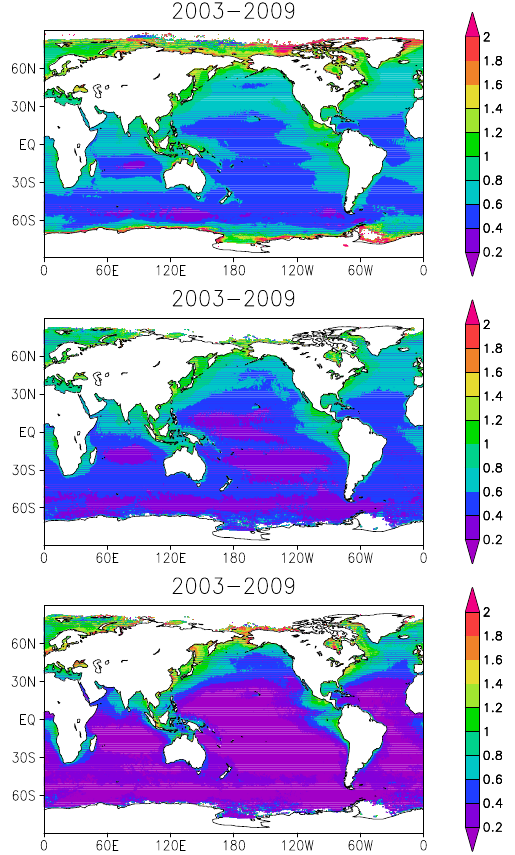
Fig. 15. Multi-year averages (2003–2009) of MODIS Aqua AOT. The top panel shows the original MODIS Coll. 5 level 2 product. The middle panel shows the screened product and the bottom panel shows the corrected product.